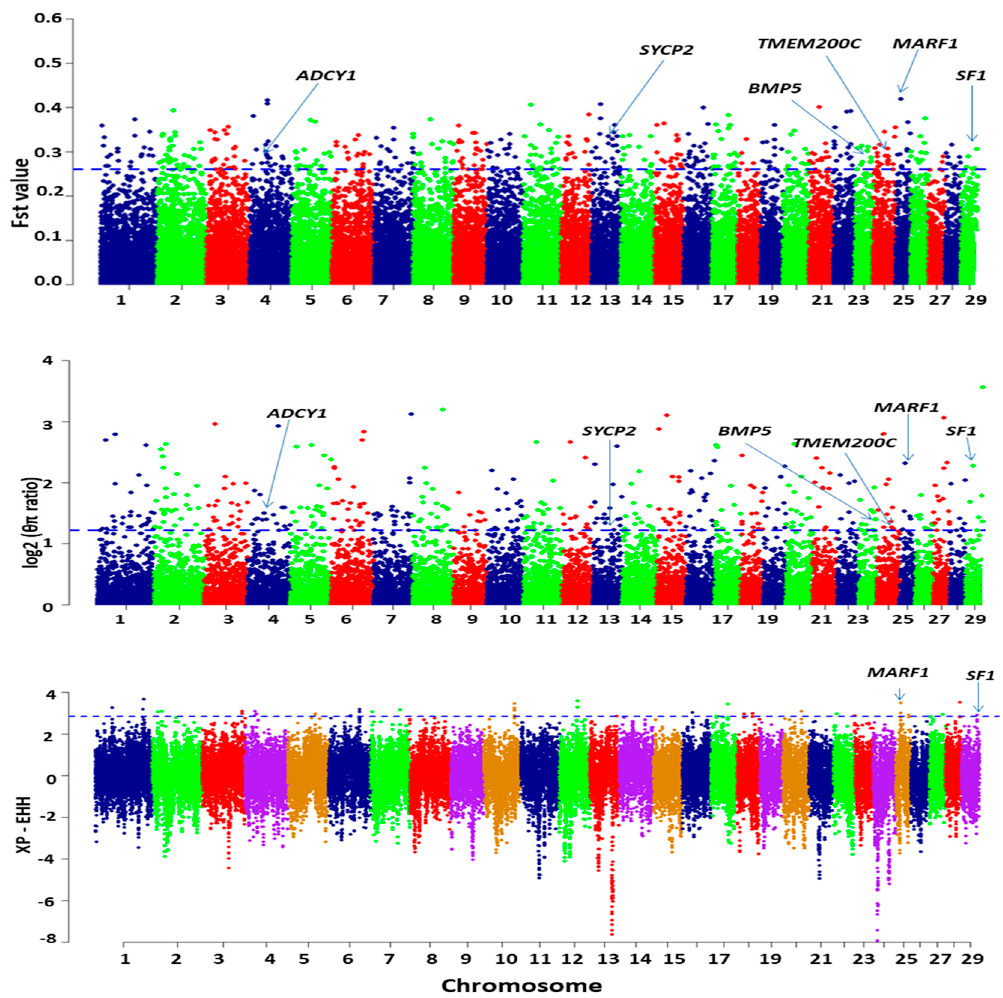
Figure 13. Selection signature detection in the high fecundity group of goat populations. Dotted lines indicate the top 1% values of F ST, and π , and 0.1% values of XP-EHH.